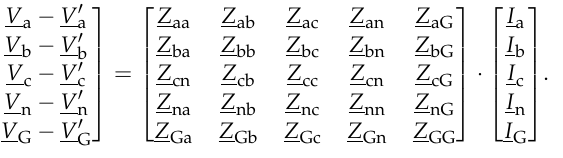
Figure 6. Five-conductor line model, including the ground return path, based on Reference [20,25]. Voltages in Figure 6 are defined relative to the transformer’s grounded neutral point, i.e., reference ground. As Figure 6 depicts a cable segment not directly connected to the transformer, V and V (cid:48) are local ground voltages of magnitudes unequal to zero. Voltage G G drop across the cable segment is described by Equation